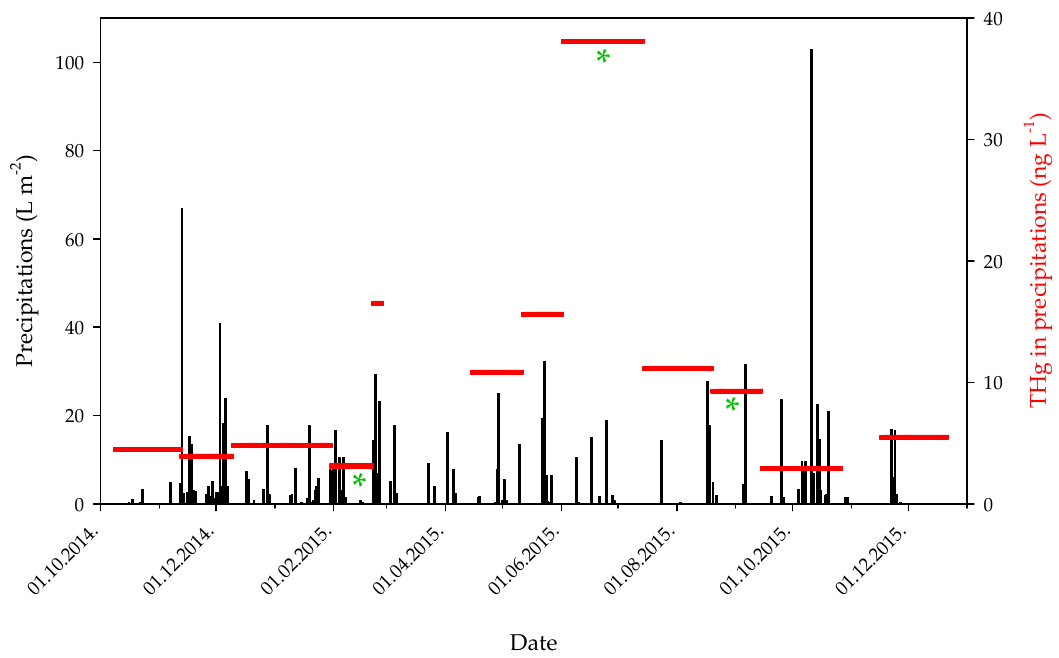
Figure 2. Daily amounts of precipitation collected at the Split-Marjan station and the average THg concentration in precipitation collected at the Institute of Oceanography and Fisheries from October 2014 to December 2015. Length of red horizontal bars indicates the precipitation collection period; the absence of the red horizontal bar indicates that THg was not determined in precipitation due to low sample volume. An asterisk indicates period without corresponding seawater sampling.